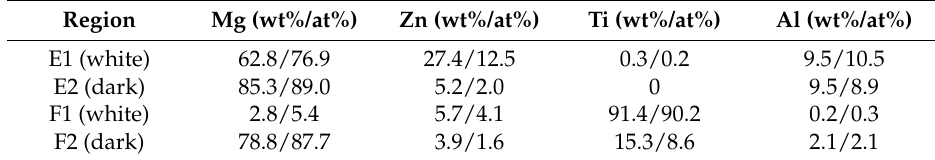
Figure 9. The fractured surfaces of bond made at 30 min. ( A ) Mg side. ( B ) Ti side. Table 3. Corresponding EDS weight/atomic composition for Figure 9.